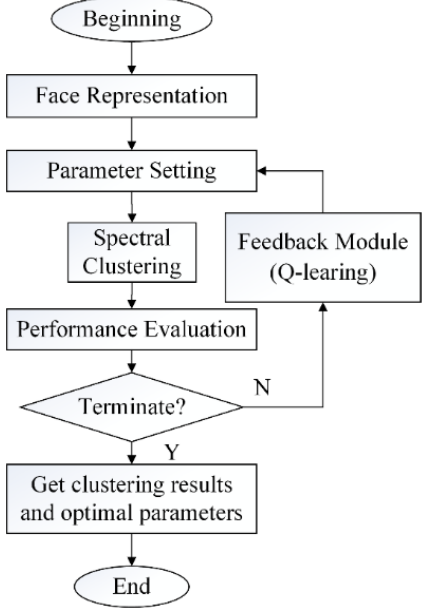
Figure 1. The diagram of our proposed adaptive facial imagery clustering. First, the face feature vectors are obtained. Second, the images are clustered according to the set parameters. Third, the parameters are adjusted by evaluating the clustering results. Finally, we repeat the second and third steps, and output the clustering results and parameters when the results meet our set requirements.